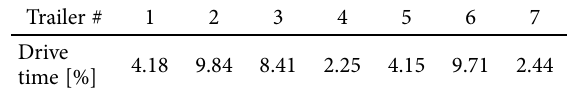
Table 5. Percentage of the driving time under combined load Trailer